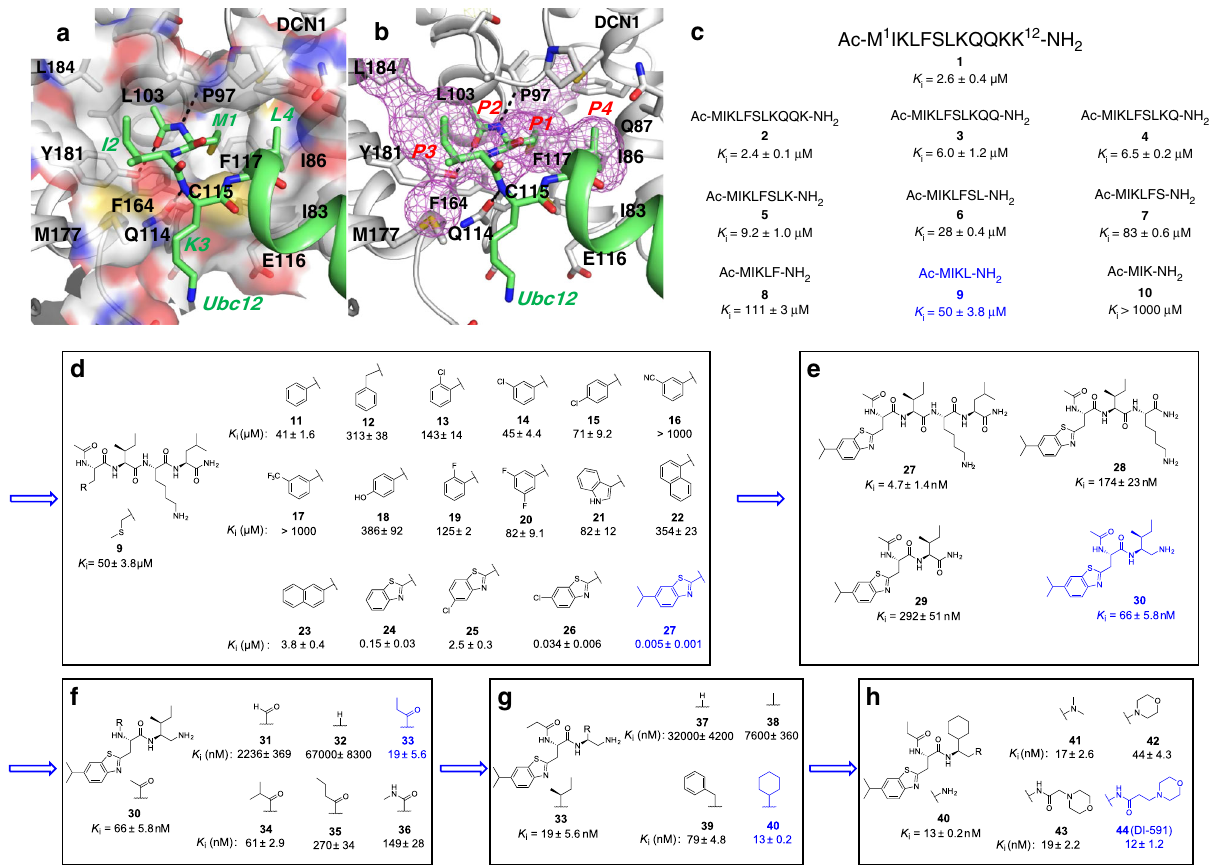
Fig. 1 Structure-based design of inhibitors of the DCN1 – UBC12 interaction. a Crystal structure of DCN1 complexed with UBC12 peptide (green). b Hydrophobic hotspots (purple mesh) at the UBC12 peptide binding site identi fi ed by co-solvent mapping. Subsites for design and optimization are labeled. c Truncation study of the UBC12 peptide. d Structures and binding af fi nities of tetrapeptide 9 and its analogs with Met1 modi fi cations. e Structures and binding af fi nities of compound 27 and its analogs with reduced molecular weights and improved aqueous solubility. f Structures and binding af fi nities of compound 30 and its analogs with acetyl group modi fi cations. g Structures and binding af fi nities of compound 33 and its analogs with Ile modi fi cations. h Further optimization of the potency and physical properties of compound 40 yielding compound 44